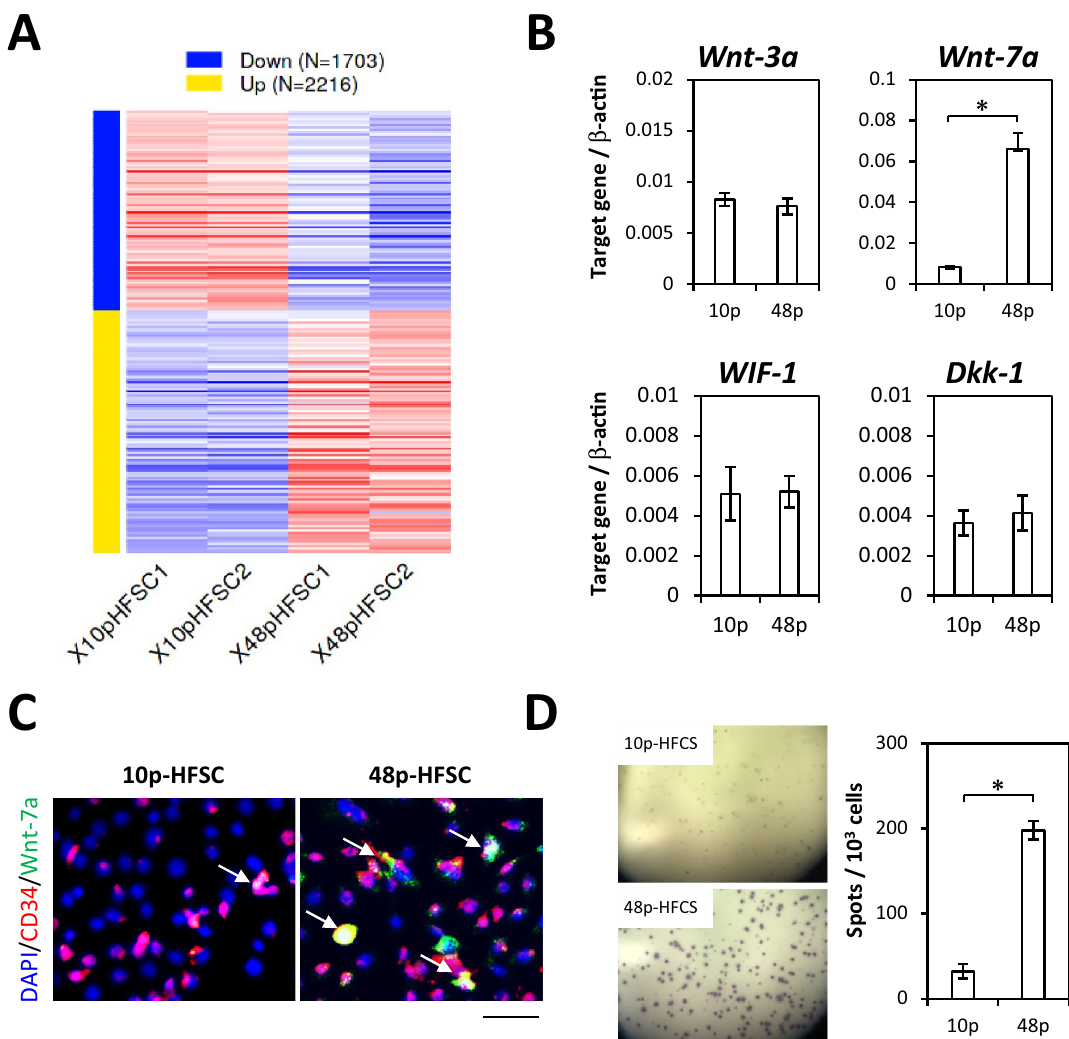
Figure 8. Altered characteristics of HFSCs after long-term passaged culture with M-CnT. ( A ) Heat map of significantly regulated genes in 10p- and 48p-HFSCs passaged with M-CnT during long-term culture produced using RNA-seq method. Data were visualized GO enrichment genes of differentially expressed genes (DEGs) extracted using the online application iDEP (ver. 0.951, http:// bioin forma tics. sdsta te. edu/ idep/). ( B ) Gene expression analysis of Wnt-3a , Wnt-7a, Wif-1 , and Dkk-1 in 10p- and 48p-HFSCs using qRT-PCR. * p < 0.05. ( C ) Immunocytochemical analysis of CD34 (red) and Wnt-7a (green) in 10p- and 48p-HFSCs passaged with M-CnT during long-term culture. Arrows indicate CD34- and Wnt-7a-double immunopositive cells. Scale bar = 50 mm. ( D ) ELISPOT assay of Wnt-7a in 10p- and 48p-HFSCs. * p <